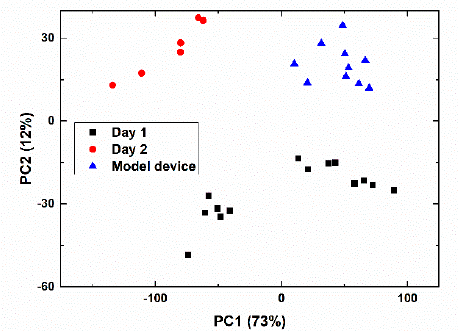
Figure 3. Principal component analysis ( PCA) score plot for samples from the Zelenogorsk water treatment plant.